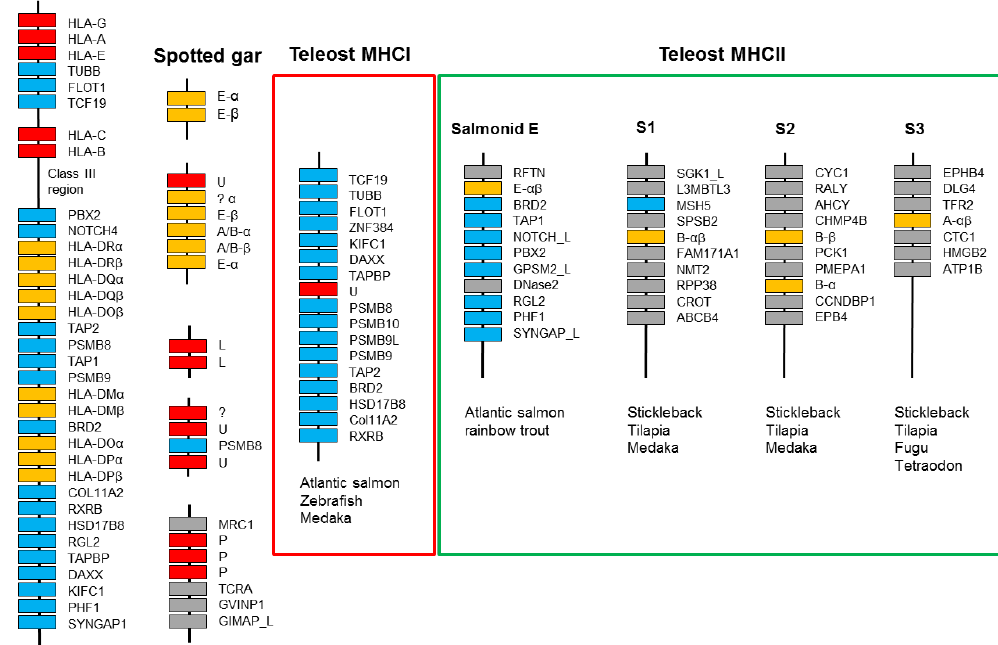
Figure 8. Schematic presentation of selected MHC regions. Red boxes represent MHCI genes, orange boxes MHCII genes, cyan boxes are genes shared with the human MHC region, while grey boxes are genes without such synteny. Only relevant genes within the 4 Mb human MHC region are shown and the region is not drawn to scale. The chromosomal organization of the spotted gar MHC regions is currently unknown, where sequences of undefined MHC lineages are shown using a question mark. Only syntenic genes within the teleost MHCI region present in the three representatives of Ostariophysi (zebrafish), salmonids (Atlantic salmon), and neoteleosts (medaka) are shown. For MHC class II, both lineage/group and type of molecule (alpha or beta) are shown, where the number of class II genes display some variation between species. Synteny regions S1–S3 are the only three syntenic MHCII regions found in some neoteleosts. These regions have lost most of the typical MHC region genes still present in the salmonid E region. Details on the ray-finned MHC regions can be found in [18,19].